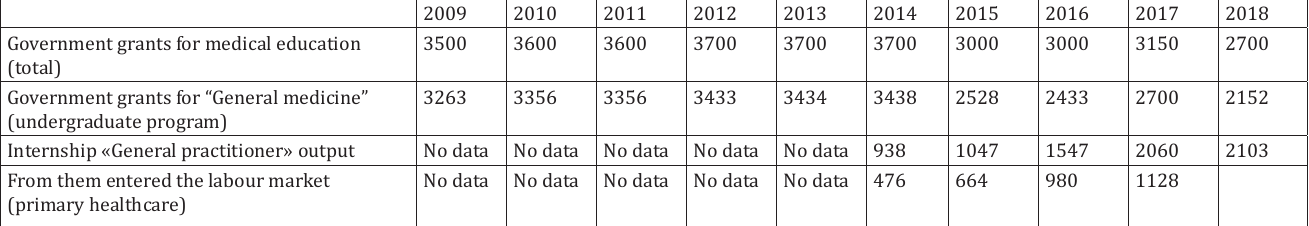
Number of students in medical